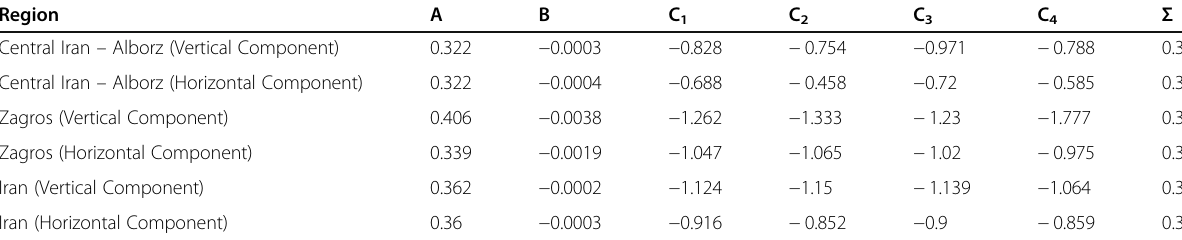
Table 1 Attenuation relationship components (Zare et al.,